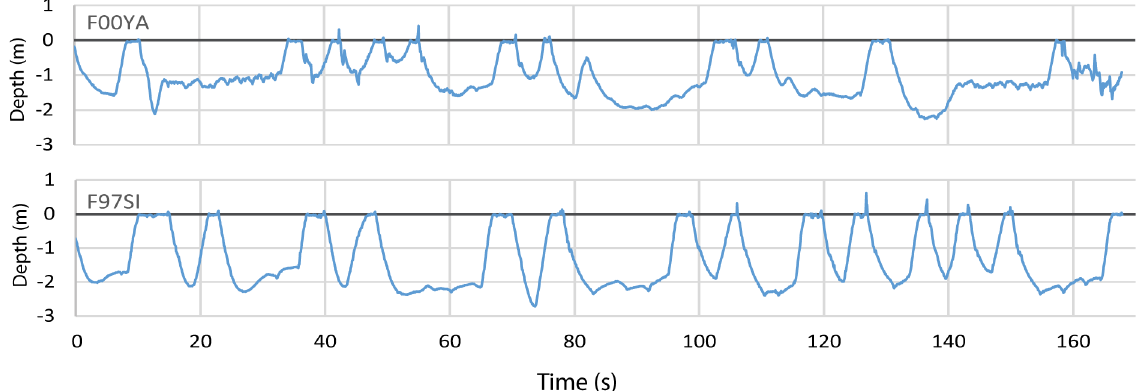
Fig 9. Samples of dive profiles for two